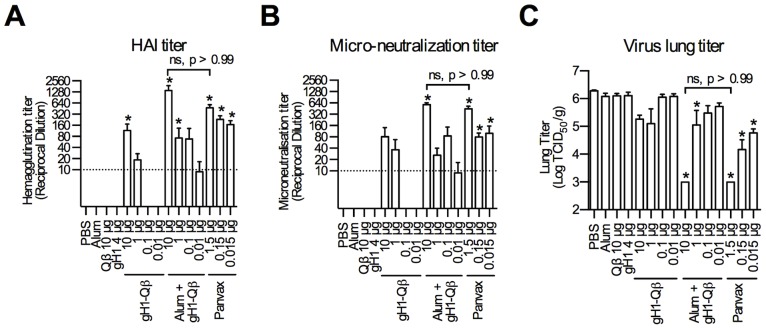
Alum-adjuvanted gH1-Qβ performs as well as Panvax in mice vaccinated and then challenged with the 2009 pandemic influenza strain.Groups of five BALB/c mice were immunized subcutaneously at days 0 and 28 with indicated doses of gH1-Qβ (either alone or adjuvanted with alum) or Panvax. Shown are the means (and standard errors) of serum hemagglutination inhibition (HAI) titers against pH1N1 2 weeks post second dose (A), virus micro-neutralization titers against pH1N1 2 weeks post second dose (B) and virus lung titers following challenge with pH1N1 3 weeks post second dose (C). One way ANOVA on the log transformed titers was used to compare groups and the significance level set at 5%. All ANOVA tests were found to be significant and were followed up with Tukey’s honest significant difference test to compare between any 2 groups. Significant differences between vaccine response and PBS control are outlined with *, p<0.05. Reported p values are adjusted to account for multiple comparisons. The abbreviation, ns, indicates no significant difference between the indicated groups.